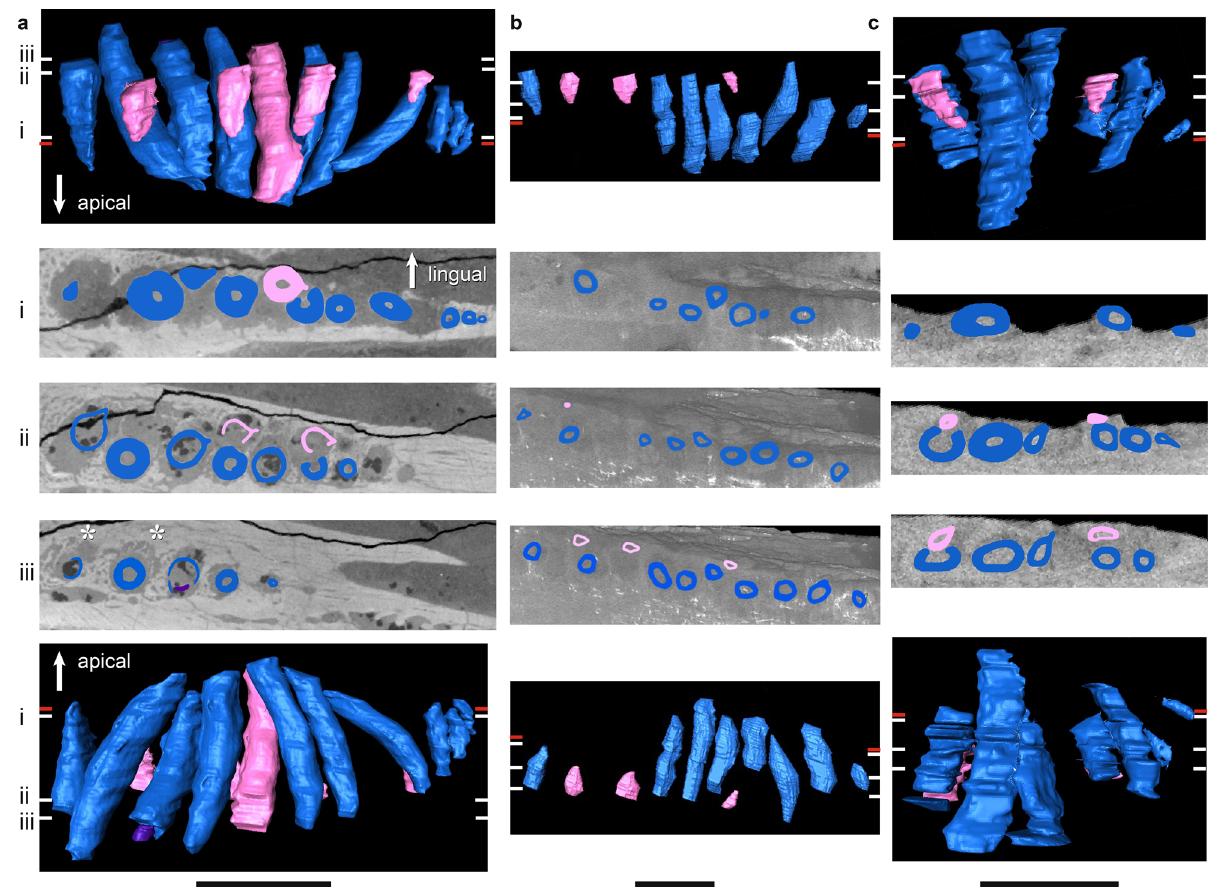
Figure 5. µCT scans of basal dicynodont mandibular ‘postcanine’ teeth in horizontal section (middle three rows), lingual view (top row), and labial view (bottom row). ( a ) Pristerodon mackayi NHCC LB190, ( b ) Brachyprosopus broomi FMNH UR 2513, ( c ) Compsodon helmoedi NHCC LB211. Horizontal sections were taken at numbered positions indicated on the labial and lingual views. The level of the gumline is indicated by a red tick mark on labial and lingual views. Replacement teeth (i.e., those that are eroding a more labial tooth) are highlighted in light pink, functional teeth in medium blue, and tooth remnants in dark purple. Anterior is to the left. Scale bars 5 mm. Asterisks indicate visible alveolar bone